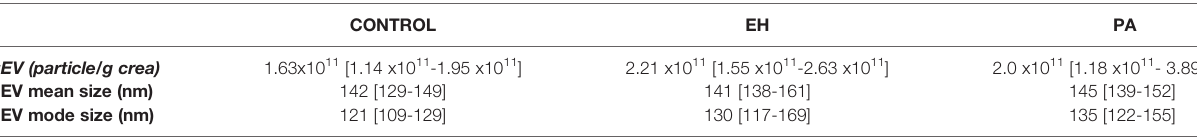
TABLE 4 | Characterization by NTA of urinary extracellular vesicles.